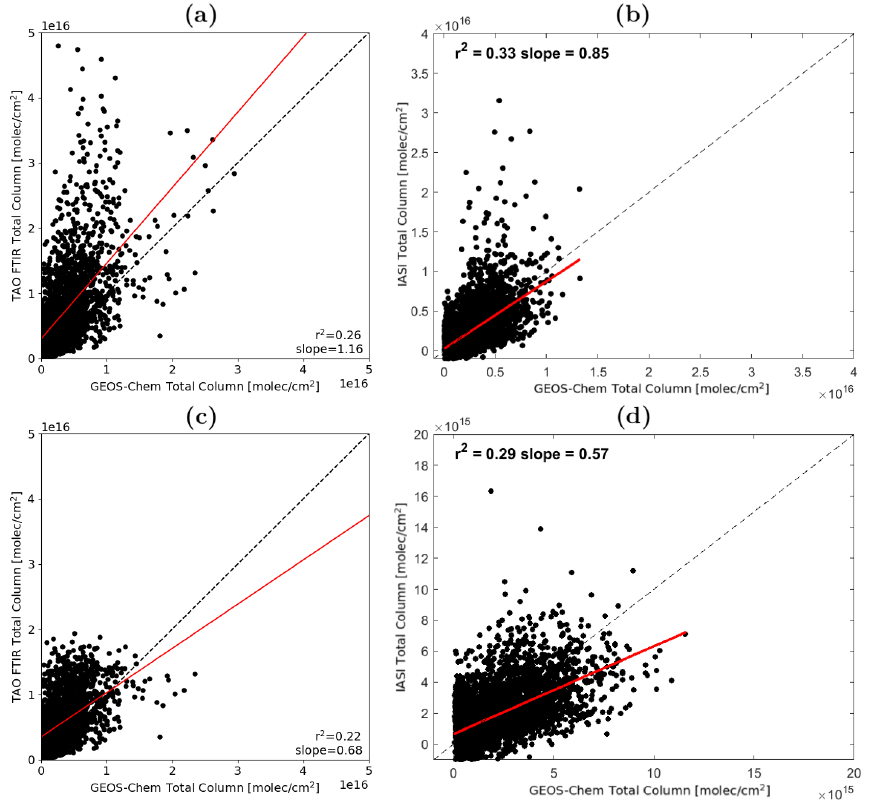
Figure 9. Correlation plots of (a) TAO FTIR vs. GEOS-Chem NH 3 total columns, (b) IASI vs. GEOS-Chem NH 3 total columns, (c) TAO FTIR with enhancement events removed vs. GEOS-Chem NH 3 total columns, and (d) IASI with enhancement events removed vs. GEOS- Chem NH 3 total columns. Data from 2002 to 2018 are plotted for TAO and data from 2008 to 2018 are plotted for IASI.